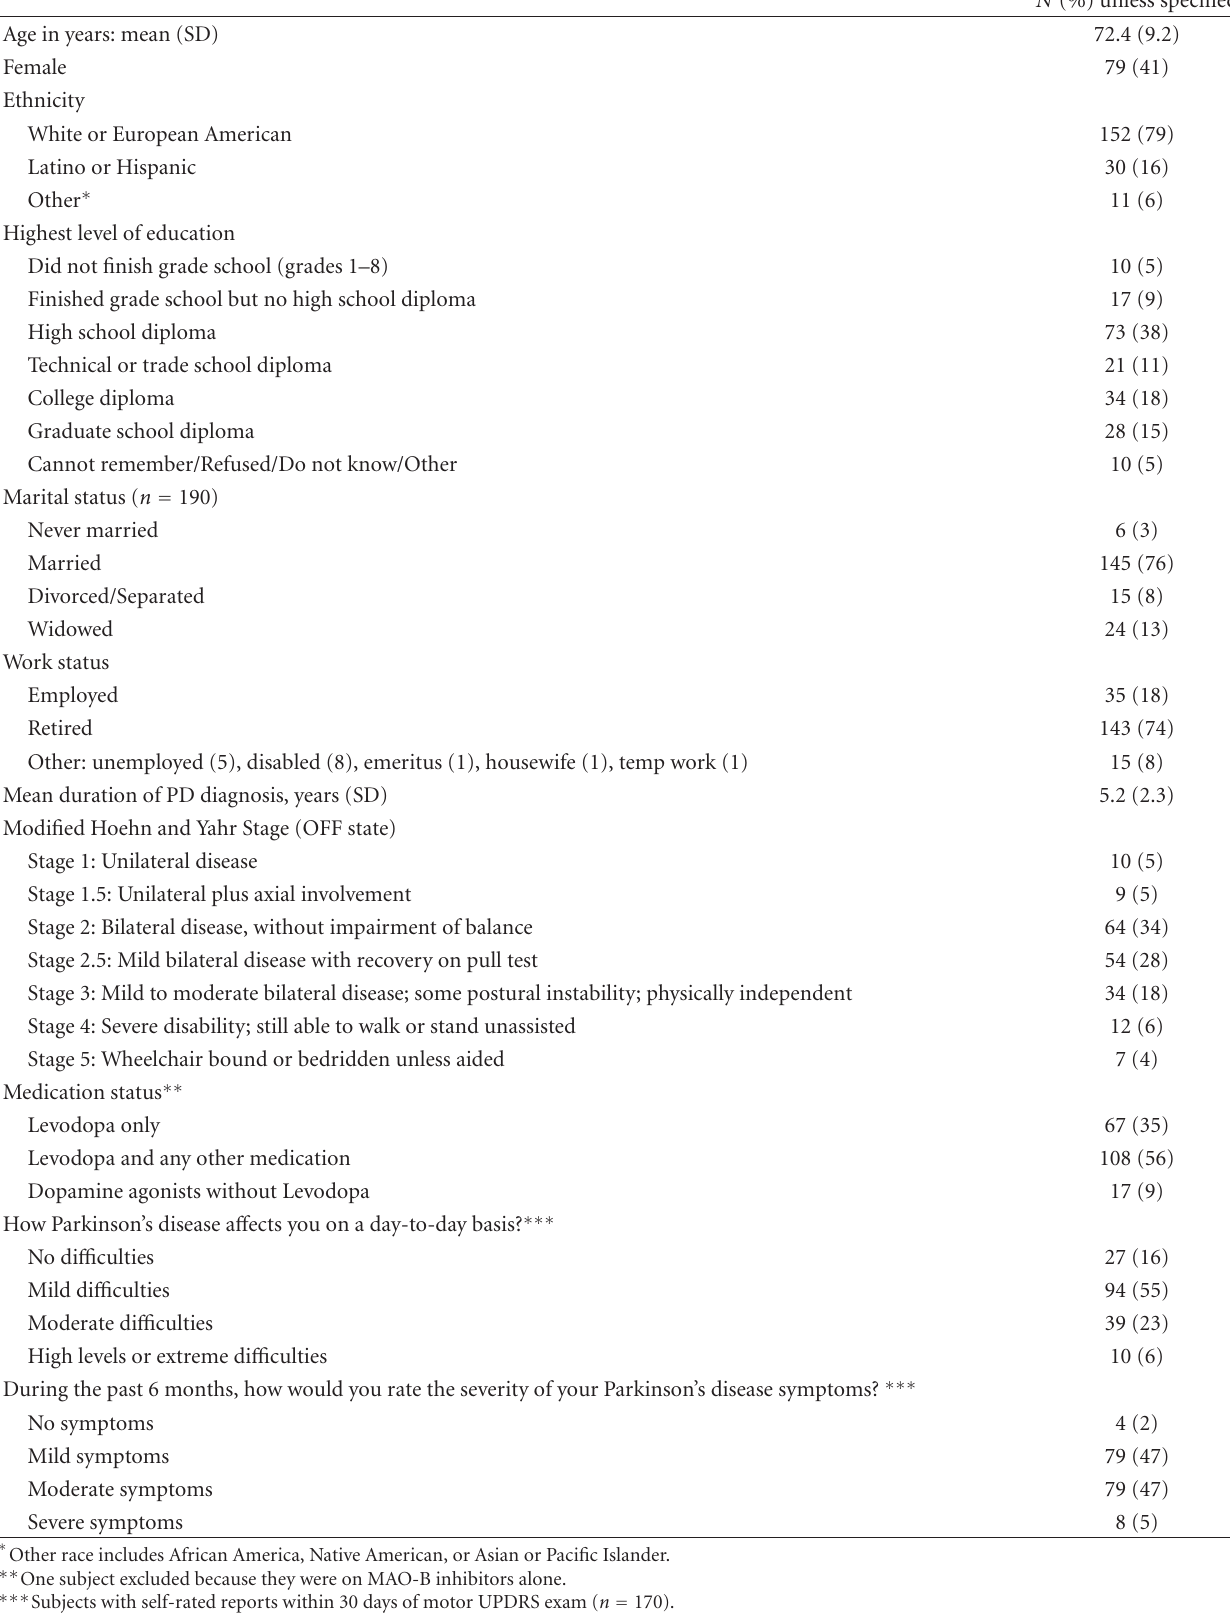
Table 1: Clinical and sociodemographic characteristics ( n =